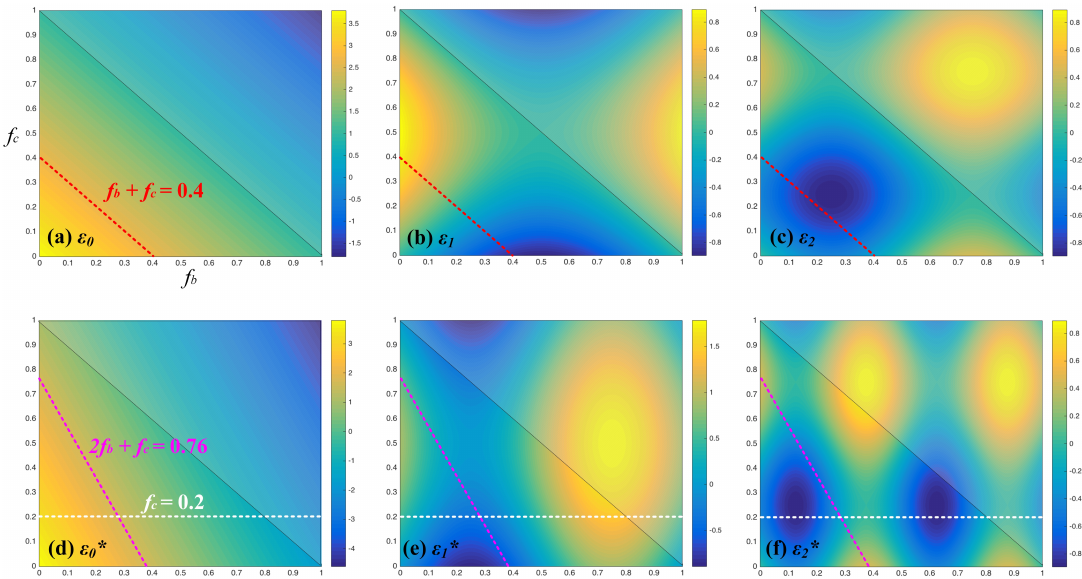
Figure 5. Amplitudes of the grating Fourier harmonics as the function of fill factors f b and f c for the two-part-period grating; ( a ) ε 0 ; ( b ) ε 1 ; and ( c ) ε 2 ; and for the three-part-period grating; ( d ) ε ∗ ( e ) ε ∗ ; and ( f ) ε ∗ . The shadow areas are not 0 0